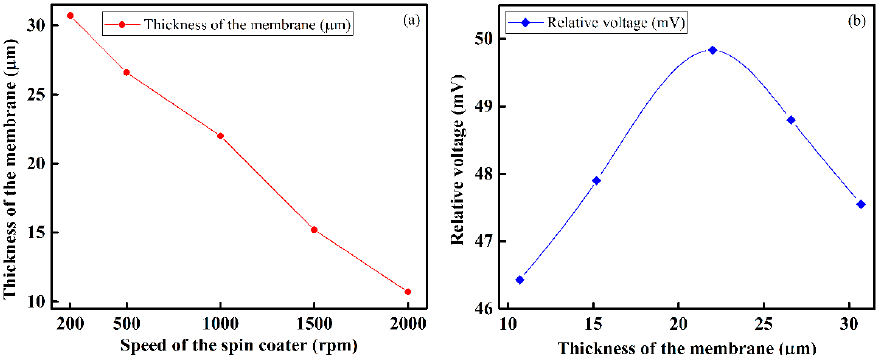
Figure 7. Characteristics of the sensing membrane: ( a ) relationship between the spin coater speed and the thickness of the IDC dielectric membrane; and ( b ) relationship between the thickness of the IDC dielectric membrane of the IDC and the obtained relative voltage.